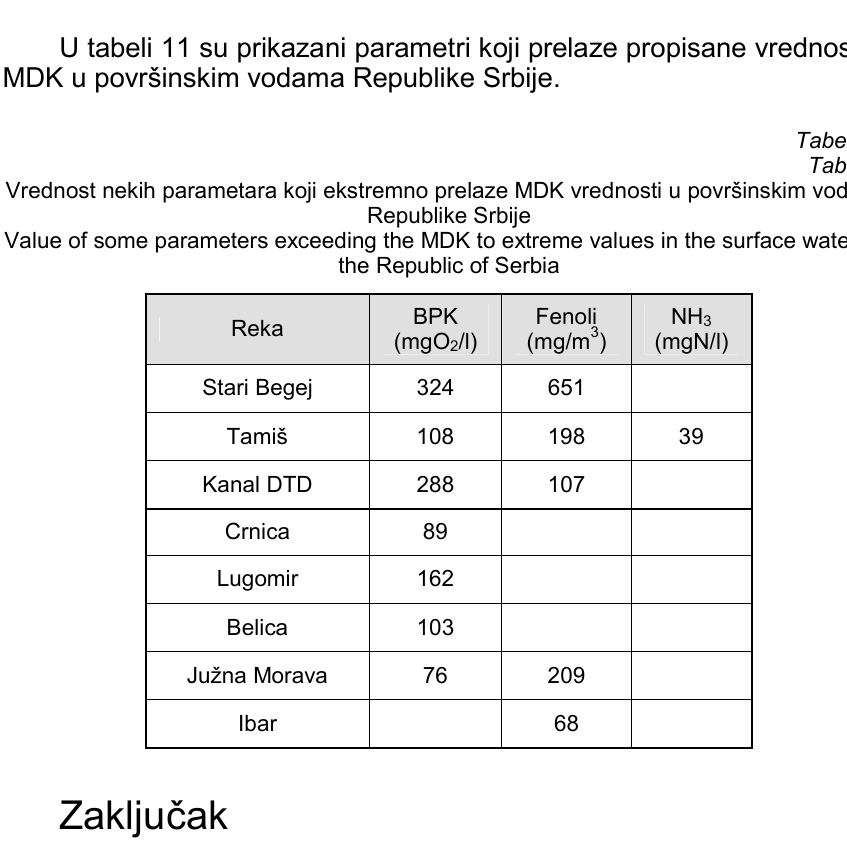
U tabeli 11 su prikazani parametri koji prelaze propisane vrednosti tj. MDK u površinskim vodama Republike Srbije.